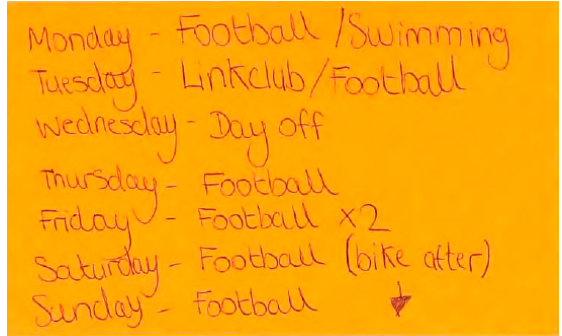
Figure 7. Show/tell data illustrating Joseph Jones’ structured leisure activities.